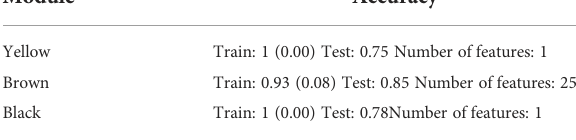
TABLE 4 Accuracy and number of features when genes in DE_Smodules were